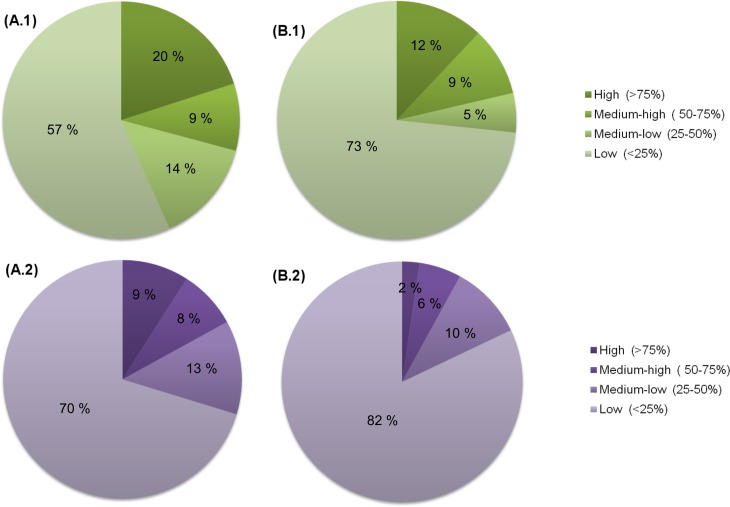
Pie charts showing the relative distribution of the viral reads through the samples, based on their presence/absence.According to the percentage of samples where a particular viral hit is identified, four categories are shown (high, medium-high, medium-low and low). Composition for reads with homology to viruses and bacteria is displayed at family (A.1) and species level (A.2). Composition for reads with homology to viruses but without homology to bacteria is also displayed at family (B.1) and species level (B.2). Green spectrum indicates family taxonomic level and purple spectrum indicates species level.